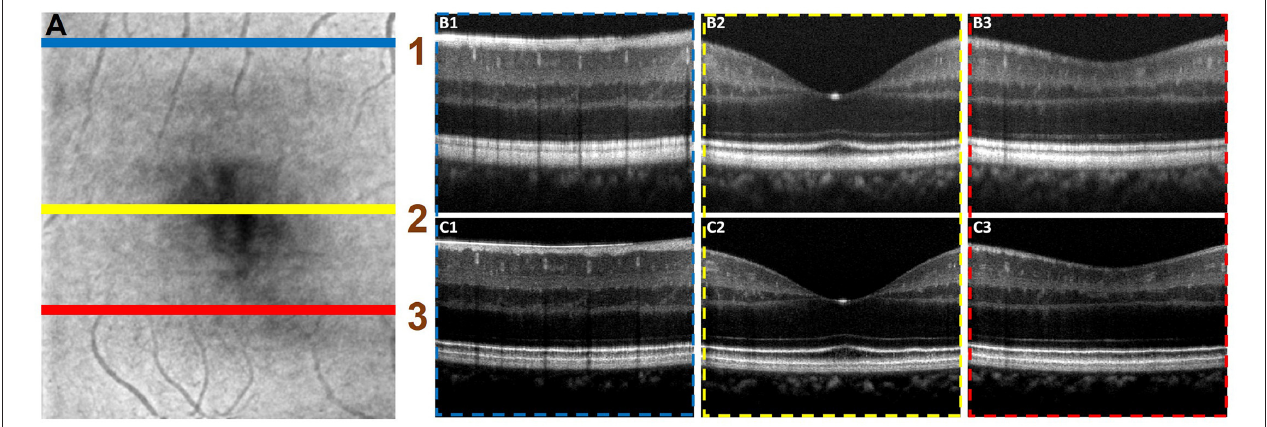
FIGURE 6 | Automated processing of 3D volume OCT dataset. (A) Depicts an enface image with the horizontal lines, line 1 (blue), line 2 (yellow), and line 3 (red), demarcating the regions from where representative B-scans were extracted. The corresponding B-scans are shown in (B,C) . The compensated B-scans (C1–C3) demonstrate higher sharpness, contrast and better visibility of structural layers when compared to the raw uncompensated B-scans (B1–B3) .